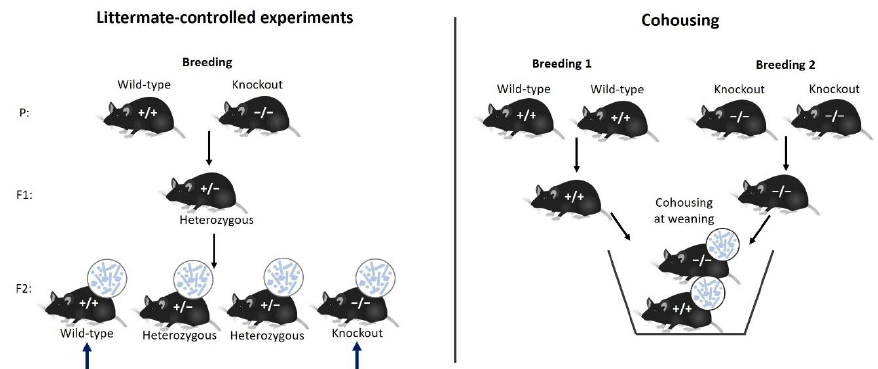
Figure 4. Littermate-controlled experiments and cohousing to standardize mouse microbiome composition within an experiment to avoid